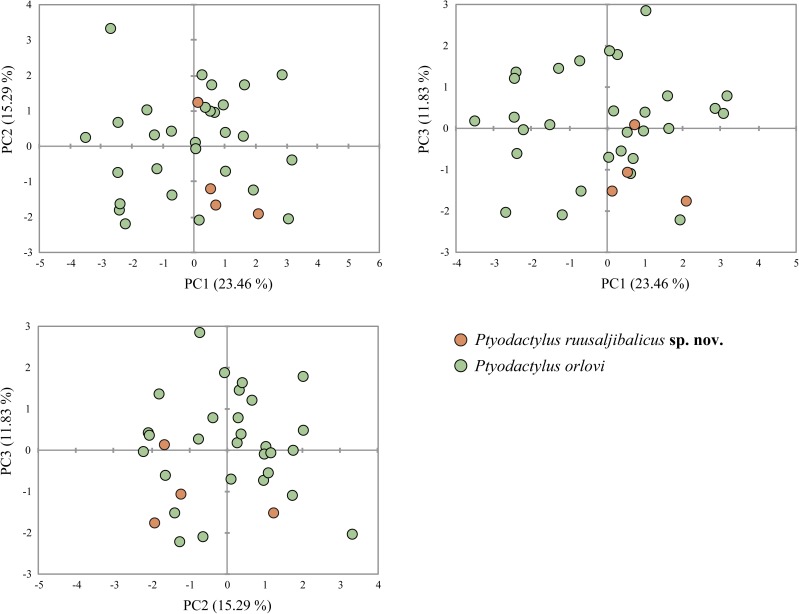
Principal Component Analysis (PCA) of the shape related morphological data.The contribution of the first three components explaining morphological variation is given in brackets. See material and methods for details.